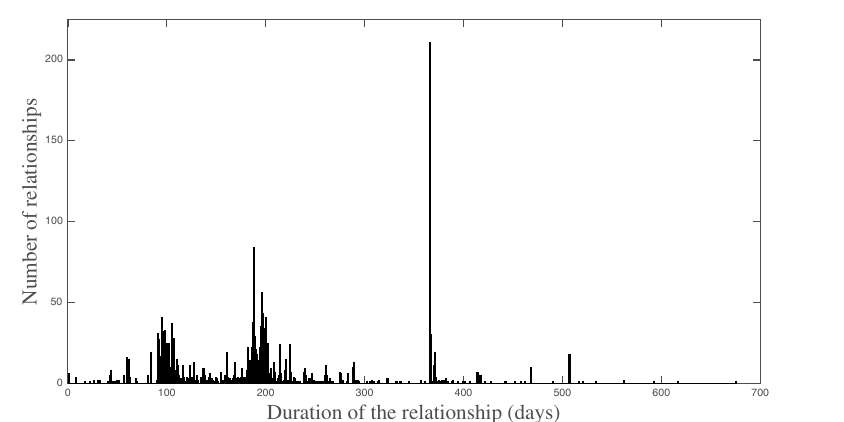
Figure 1. Frequency distribution for the duration of the relationships of the 2428 nodes in the temporal